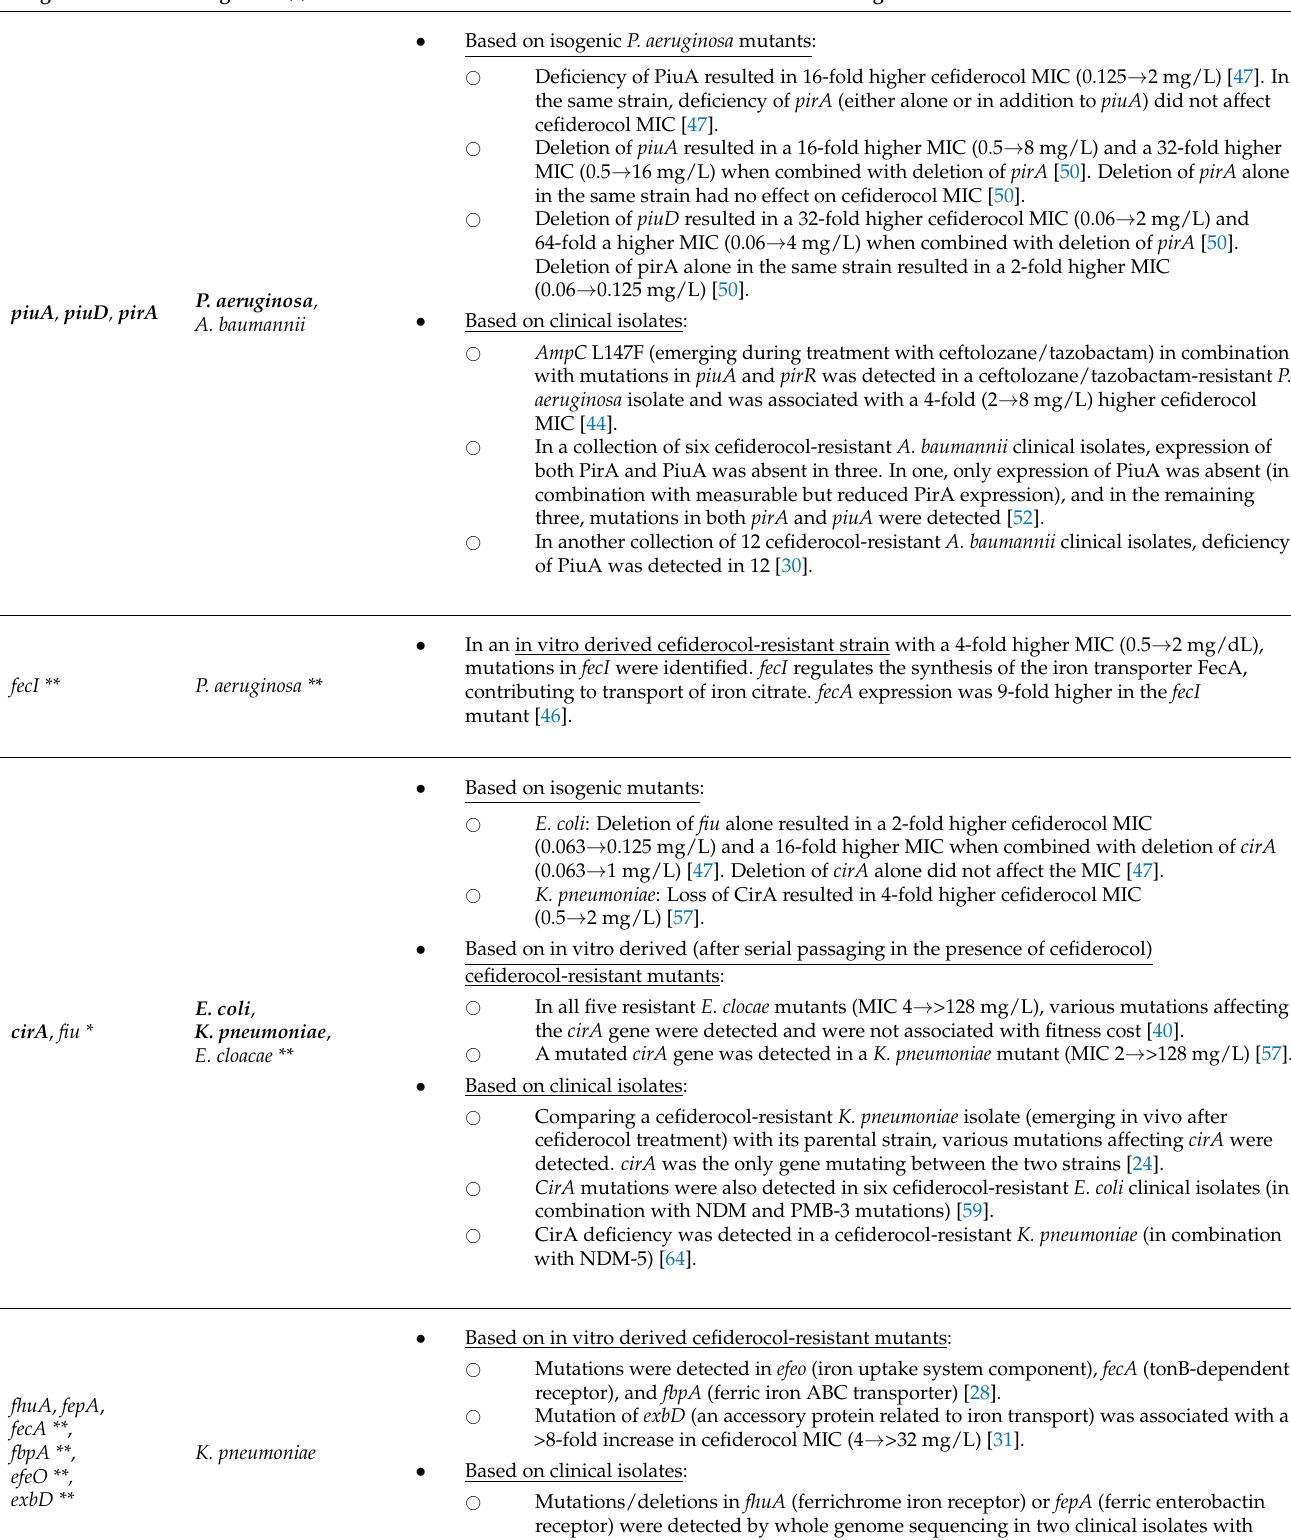
Table A2. Resistance mediated by mutations affecting siderophore receptors. Target Gene Organism(s)